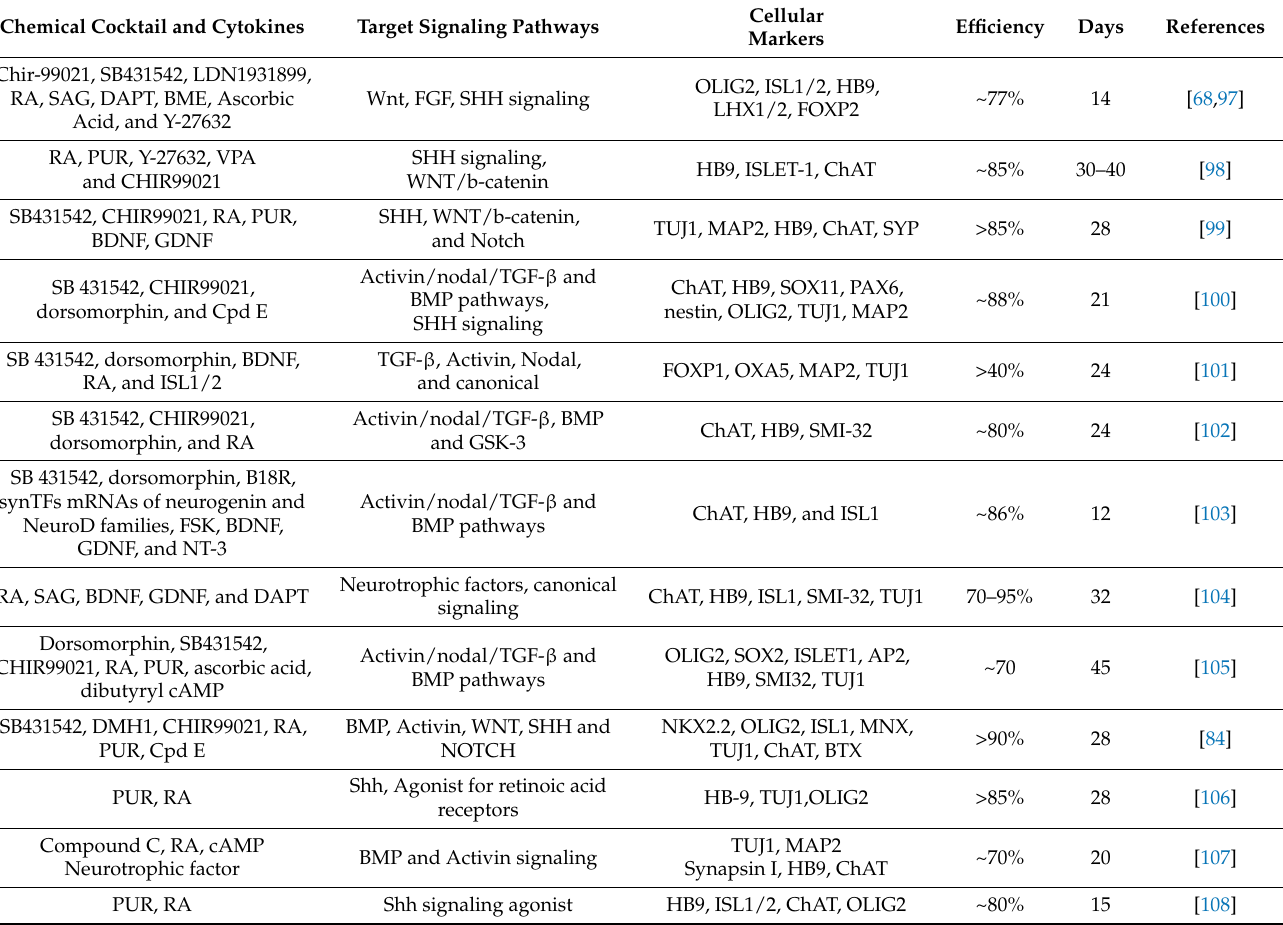
Table 3. Chemical cocktails used for MN differentiation from